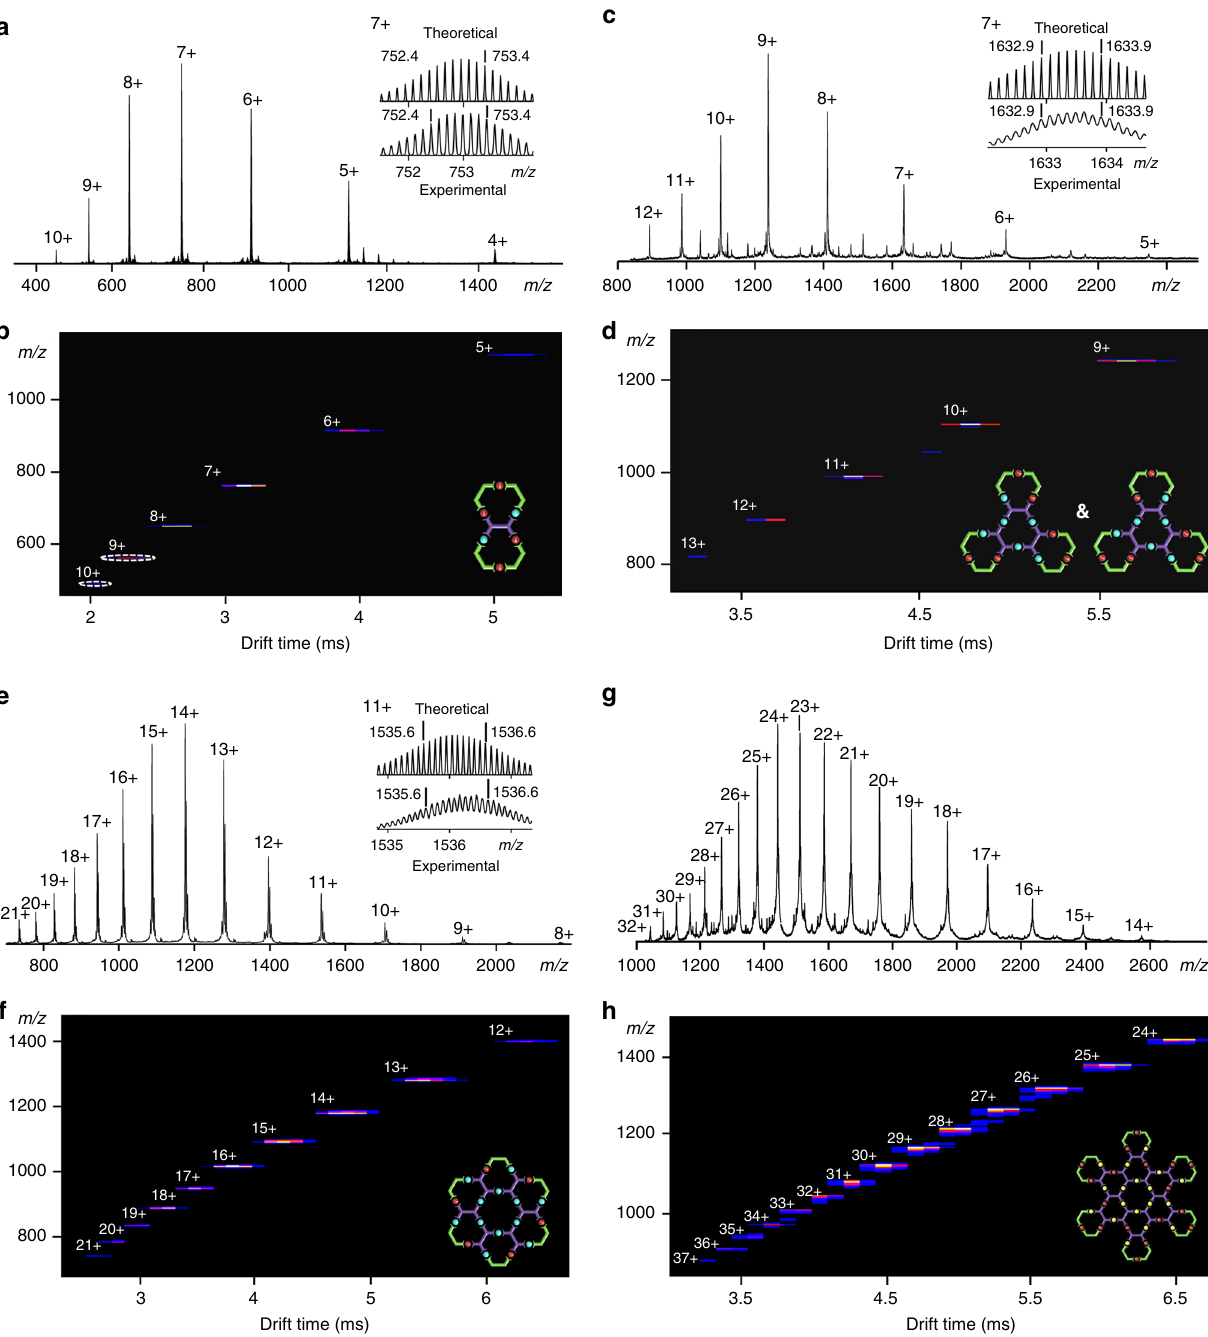
Fig. 3 Mass spectrometry for supramolecules C2 – C5 . Electrospray ionization – mass spectrometry (ESI-MS) for C2 ( a ); C3 ( c ); C4 ( e ) and C5 ( g ). Traveling wave Ionmobility – mass spectrometry (TWIM-MS) for C2 ( b ); C3 ( d ); C4 ( f ) and C5 ( h